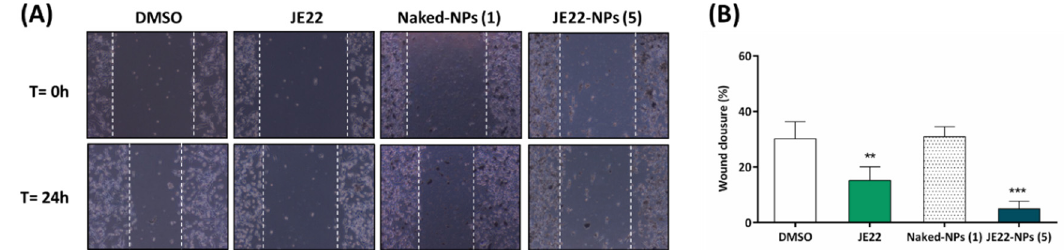
Figure 8. Scratch-wound migration assay. ( A ) Snapshots of the scratch-wound area of MDA-MB-231 cells treated with DMSO, JE22 , Naked-NPs ( 1 ), and JE22-NPS ( 5 ) at time zero (top) and after 24 h (bottom). White lines highlight the gap created by the scratch. ( B ) Bar graph showing the percentage of wound closure of MDA-MB-231 cells after treatment with JE22 and JE22-NPs ( 5 ) compared to untreated cell control (DMSO) and cells treated with Naked-NPs ( 1 ), respectively. Error bars: ±SD from n = 3; p < 0.01, **; p < 0.001, *** (ANOVA).